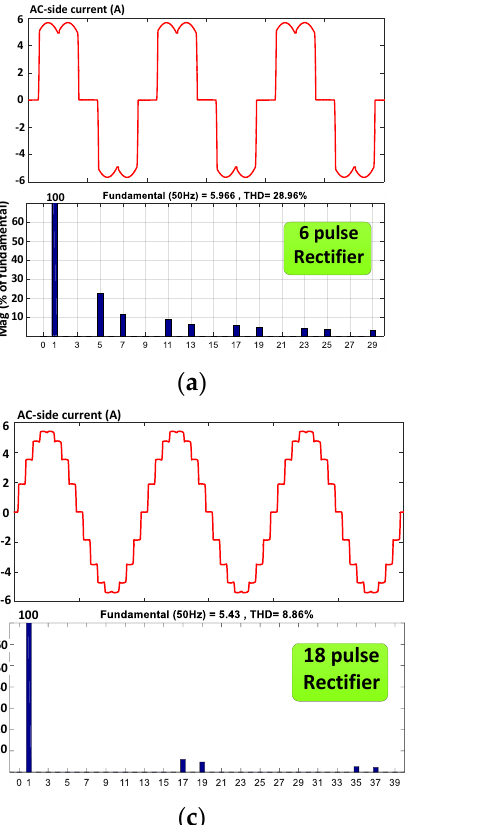
( b ) Figure 2. The harmonic spectrum of the traditional and modern trains. ( a ) Traditional SS4 locomotives. ( b ) High-speed modern CRH2 locomotives [24]. 